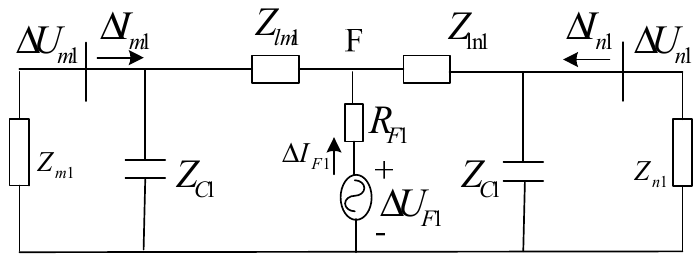
Figure 4. Positive sequence network diagram of fault components.